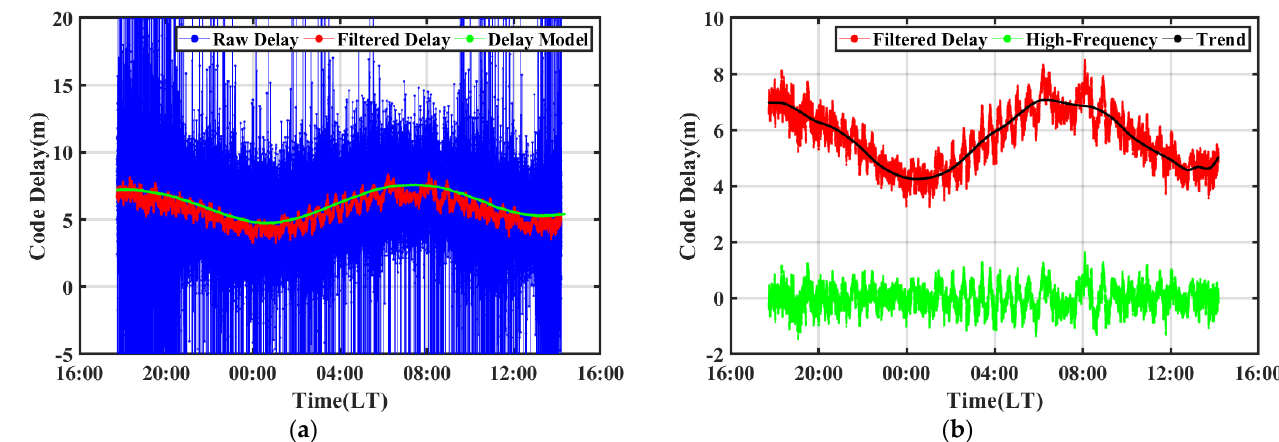
Figure 7. The code delay measurements during 23 h experiment: ( a ) The comparison between the raw code delay measurements (blue), the code delay measurements with 60-s moving mean filter (red), and the code delay model from the in-situ SSH (green); ( b ) The filtered code delay measurements with the EMD method: filtered measurements (red), the trend term (the black), the high-frequency term (green).